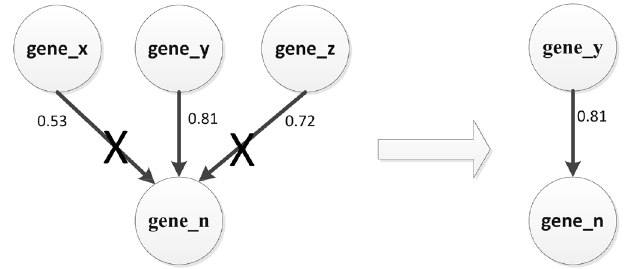
Figure 15. Screen the strongest gene regulatory